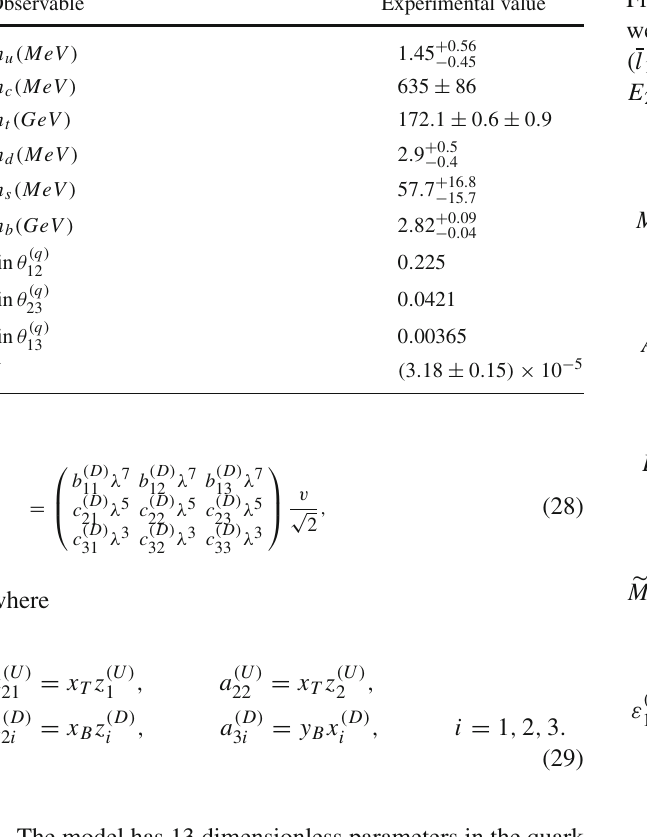
Table 3 Experimental M Z -scale values of the quark masses [123,124] and CKM parameters [125] Observable Experimental